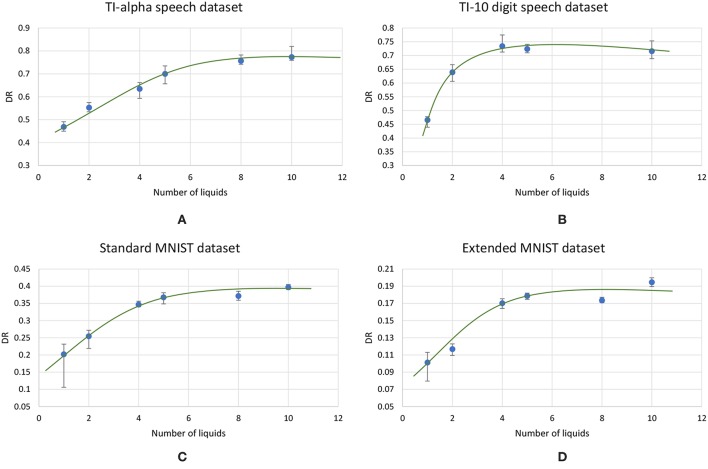
The average (over five trials) discriminant ratio (DR) trends with different number of liquids in an ensemble for two speech recognition tasks; (A) TI-alpha dataset, (B) TI-10 dataset, and two image recognition tasks; (C) standard MNIST dataset, (D) extended MNIST dataset. The total number of neurons in each ensemble of liquids were kept the same. Note that all the DR trends increase with the number of liquids, and saturates after a certain point, that depends on the application.